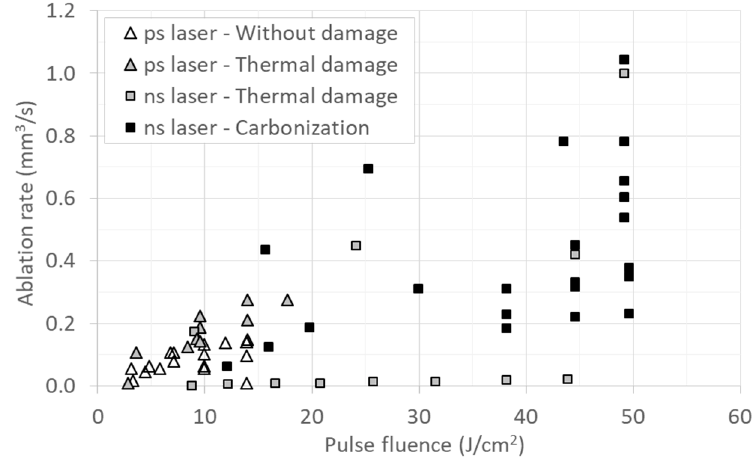
Figure 7. Ablation rate versus laser pulse fluence for samples obtained with the UV ns and IR ps lasers, classified by the thermal damage observed.